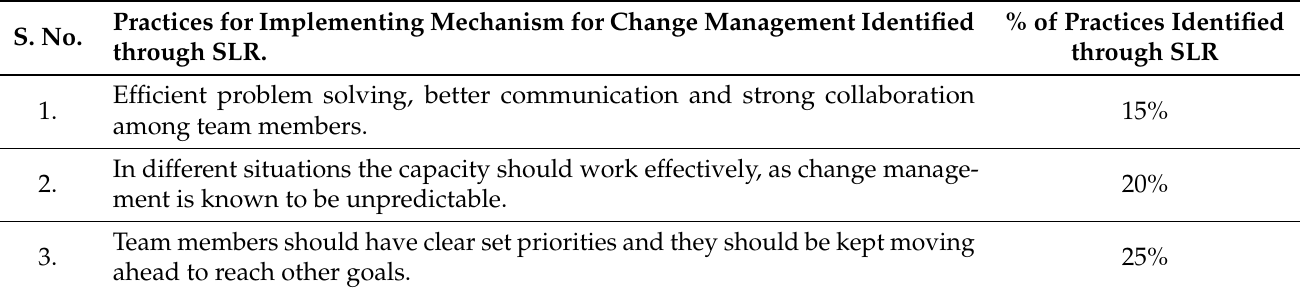
Table 19. Practices for implementing mechanism for change